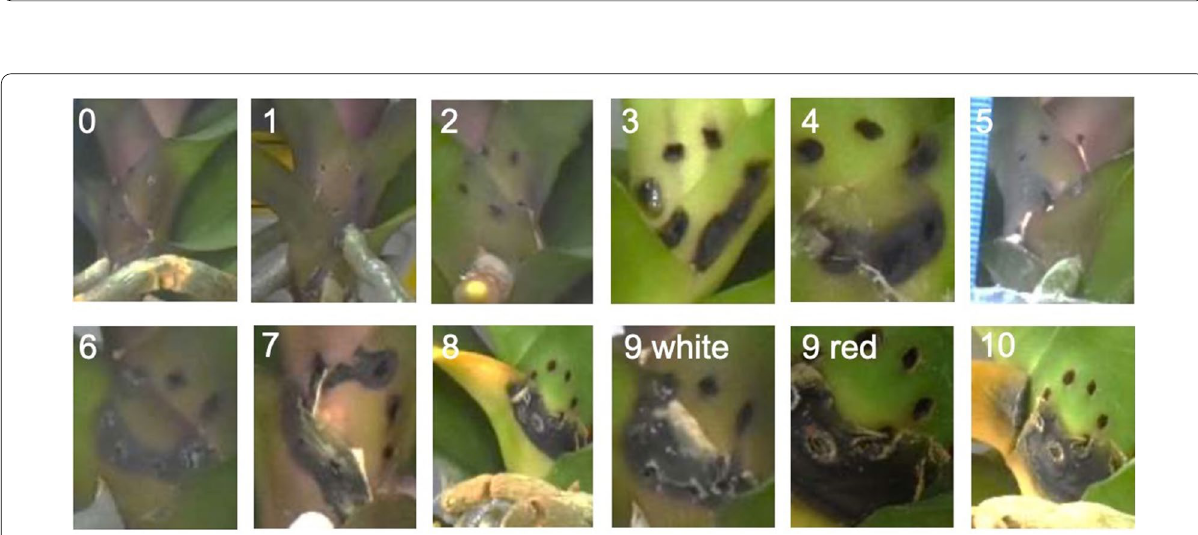
Fig. 1 Severity rank of detached leaf. (0): no symptom; (1) Number of black holes less than 3; (2) Number of black holes between 4–7; (3) Black holes connected together; (4) Black spread outside of the wound; (5) Less than 3 holes filled by hypha; (6) Number of holes filled by hypha between 4 to 7; (7) The hypha mixed together; (8) Yellow symptom started; (9) Yellow symptom fill 50 % of the leaf area (10) The red symptom showed